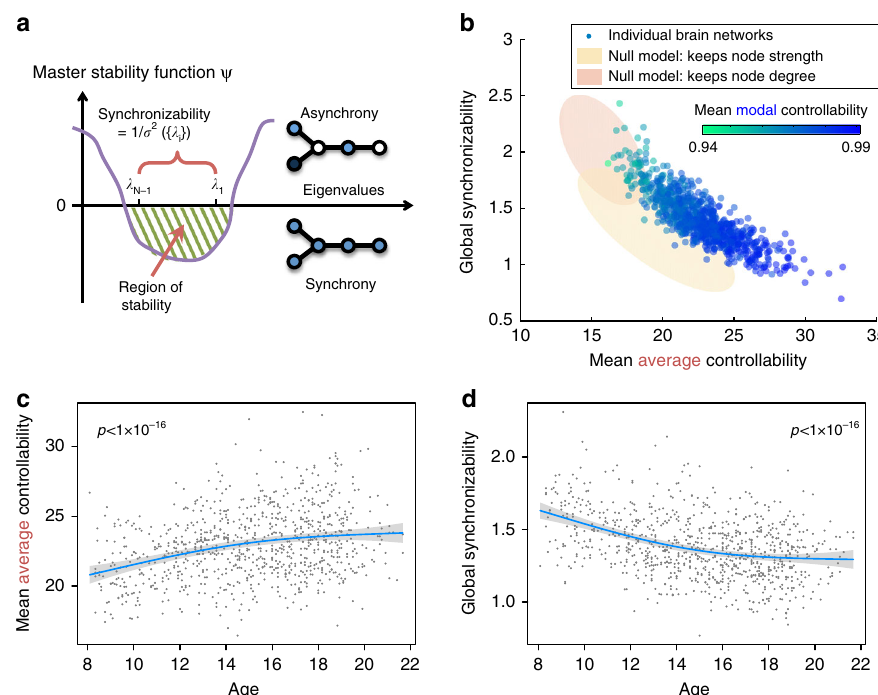
Fig. 2 Synchronizability and changes across development. a A synchronous state is operationalized as a state in which all nodes have the same activity magnitude. Such a state is stable when the master stability function is negative for all positive eigenvalues of the graph Laplacian (Methods section). We use the inverse spread of the Laplacian eigenvalues 1/ σ 2 ({ λ i }) as a measure of global synchronizability. b Global synchronizability is anti-correlated with both average controllability and modal controllability (color of circles). Yellow and red ellipses are the 95% con fi dence clouds of the node-preserving and strength-preserving null models. c Mean average controllability signi fi cantly increases with age: Pearson ’ s correlation coef fi cient r = 0.28, df = 881, p < 1 × 10 − 16 . d Global synchronizability signi fi cantly decreases with age: − 0.37, df = 881, p < 1 × 10 − 16 . The fi ts in panels c , d all control for brain volume, head motion, sex, and handedness. Blue lines show best non-linear fi t under a general additive model (see Methods); gray envelope denotes